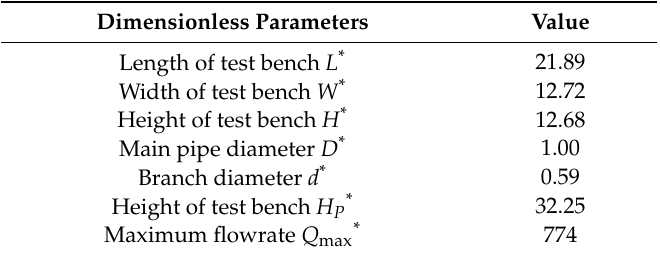
Table 2. Dimensionless geometric parameters of the experiment